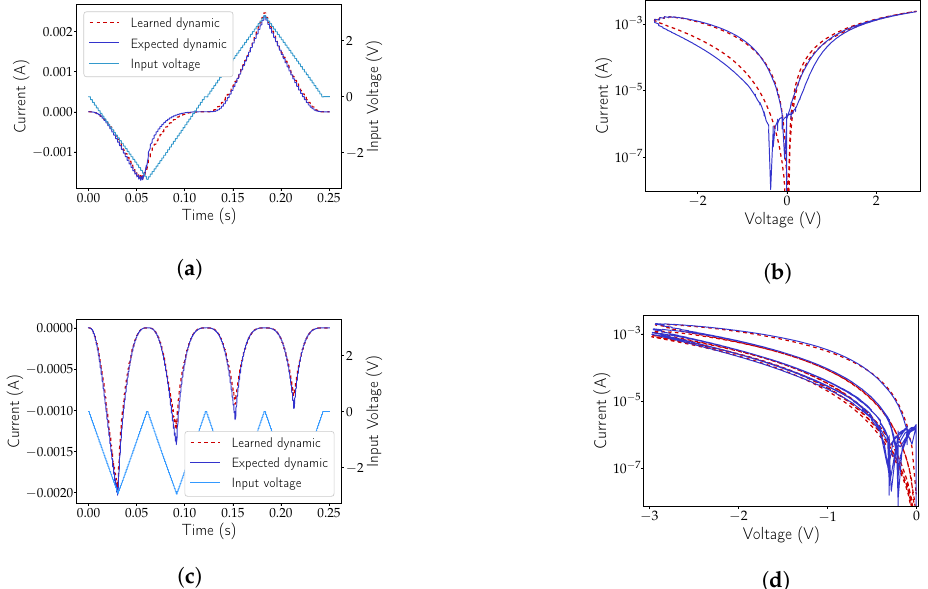
Figure 6. Expected dynamics of an a-IGZO memristor and the output of an MSNN network with external input and [ 2,50,50,1 ] topology. ( a , b ) represent the same response to a single DC sweep style input, however ( a ) is represented over time and on a linear scale and ( b ) displays the logarithmic I-V plot, commonly used to show a memristor hysteresis loop. Plots ( c , d ) represent the output of the network to a depression inducing triangular waveform. Just like in ( a , b ), the left-side image, ( c ), is a linear-time plot and the right-side image, ( d ), a logarithmic I-V representation.